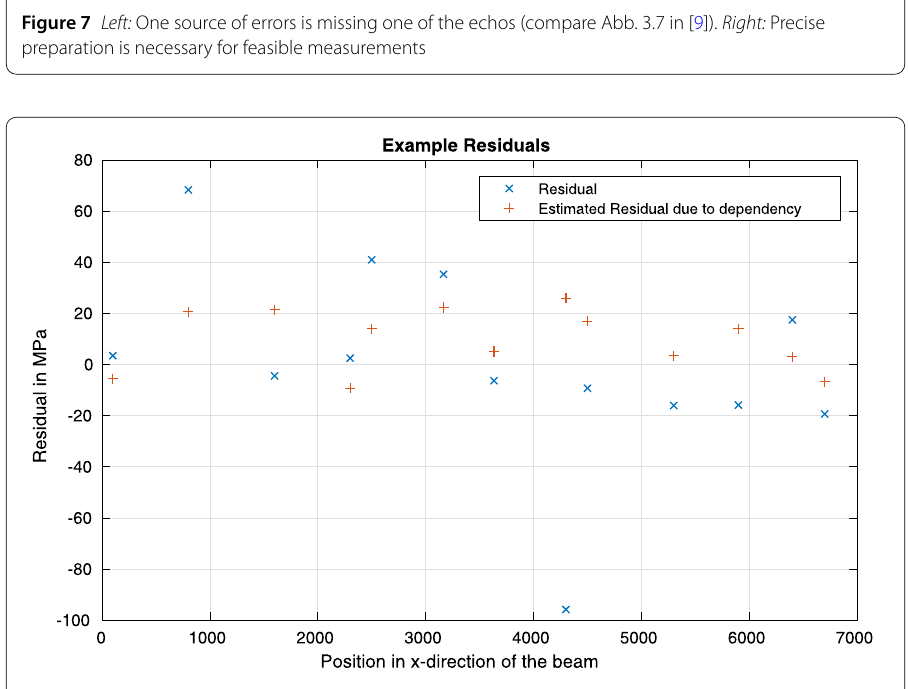
Figure 8 Residuals from real data analysis in one trace, hence 1- and not 7-dimensional. On the one hand with non-zero mean, on the other hand with structure (here: heteroskedastic, predictable). Note, that this